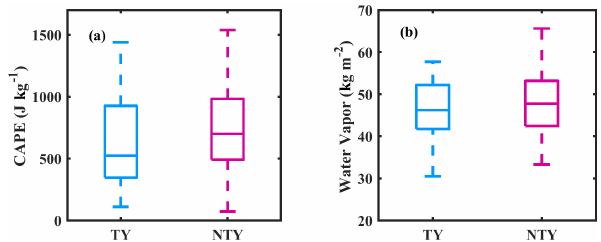
Figure 13. Variations in the (a) convective available potential en- ergy (CAPE; joules per kilogram, hereafter Jkg − 1 ) and the (b) ver- tical integral of water vapor (kilograms per square meter, hereafter kgm − 2 ) for typhoon (TY) and non-typhoon (NTY) rainfall. The center line of the box indicates the median, and the bottom and top lines of the box indicate the 25th and 75th percentiles, respectively. The bottom and top of the dashed vertical lines indicate the 5th and 95th percentiles, respectively.